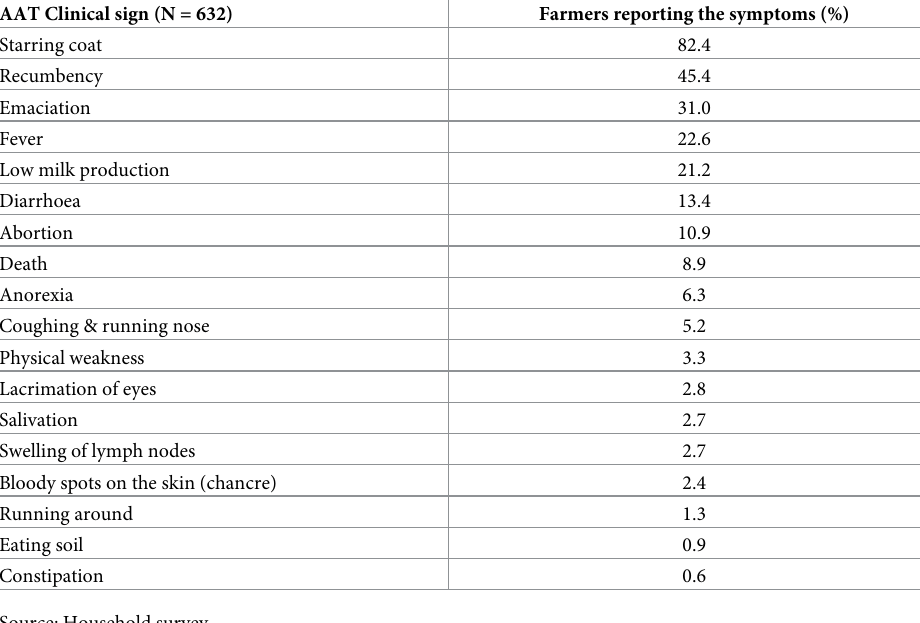
Table 4. Clinical signs trypanosomiasis reported in Kwale district (n = 632).